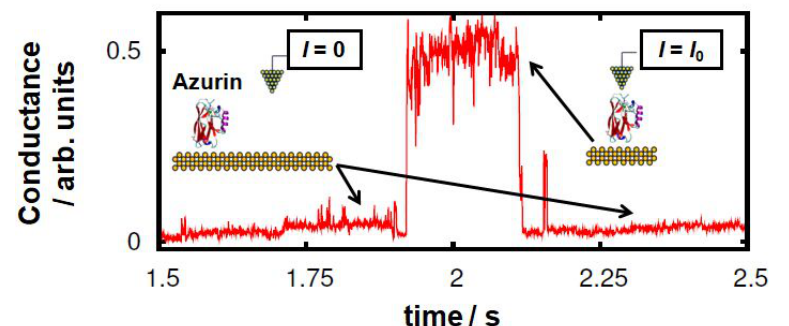
Figure 1. Representative “blink” identified in the experimental transients of the conductance relative to the current flowing between the two electrodes at a constant distance (2.5–3 nm) and V bias = 20 mV (from 1.921 s to 2.113 s in this example). This kind of event is observed when the azurin protein spans the gap between the STM tip and the Au substrate electrodes. When the protein detaches itself from one of the electrodes, the conductance drops down to the initial set point level (50 pA).